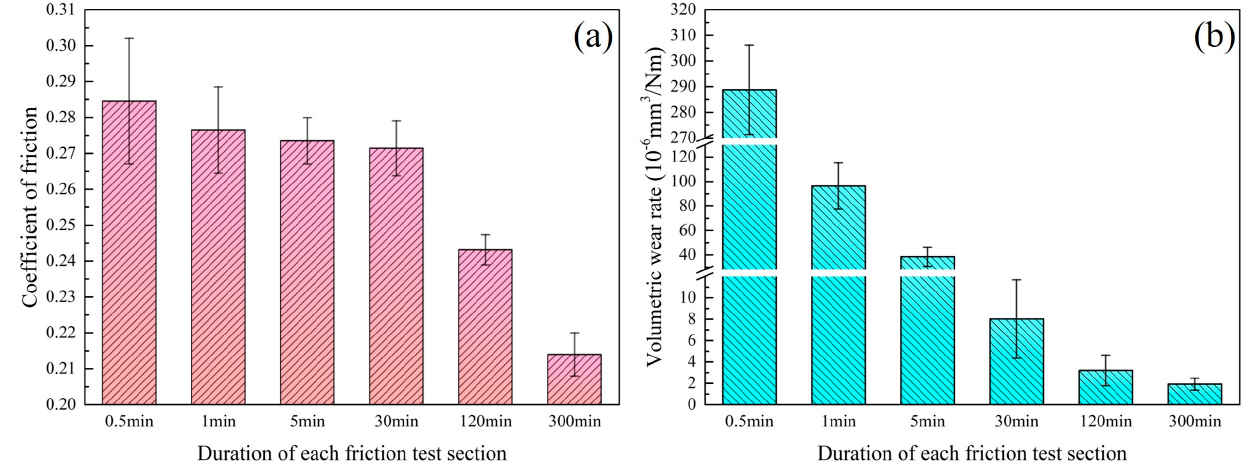
Figure 9. Tribological properties of Nano-ZrO 2 /PEEK/PTFE at different friction stages. ( a ) coefficient of friction; ( b ) volume wear rate. of friction; ( b ) volume wear